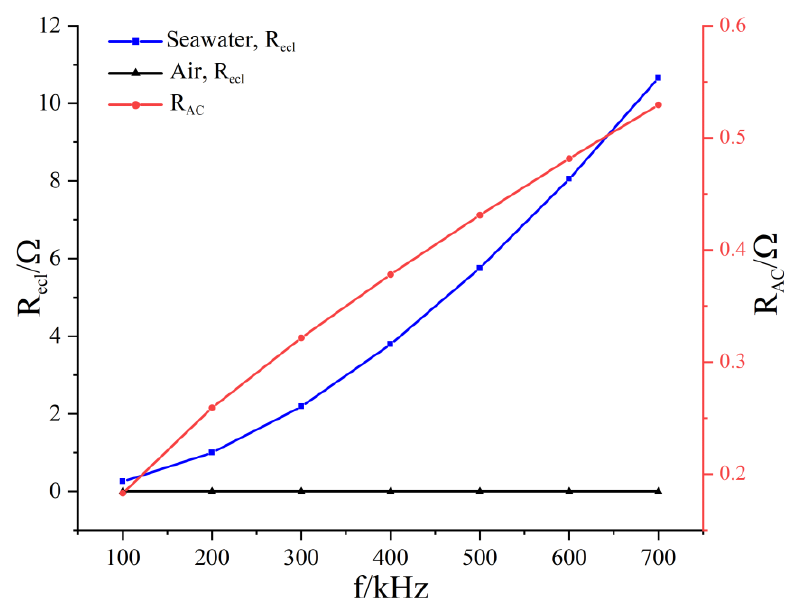
Figure 6. Variation of AC resistance and eddy current loss resistance with frequency.